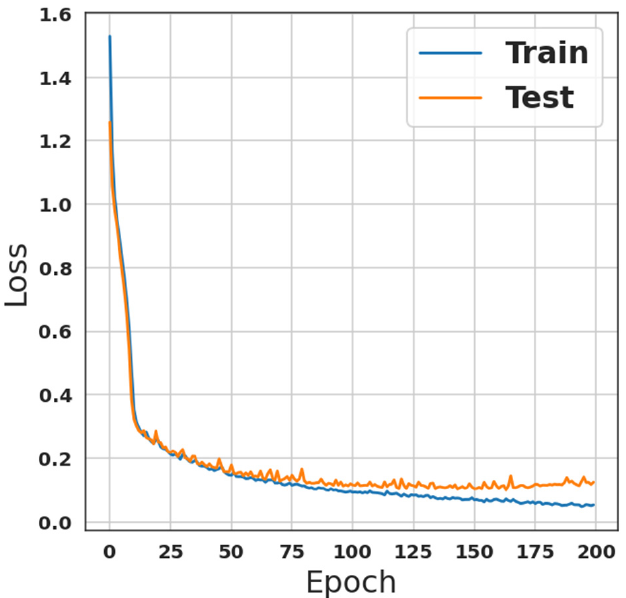
Figure 2. Loss results of the first model which is shown in Table 1 .